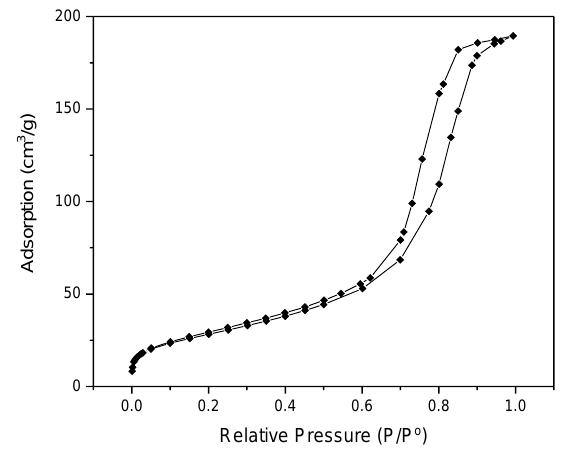
Figure 2. Nitrogen adsorption-desorption isotherm of Ni-Sn/CeAl sample.